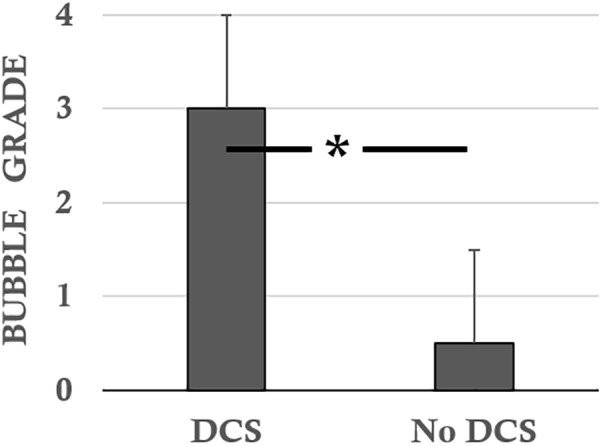
Bubble scores according to the status of the rats following the hyperbaric protocol. ∗ notes significant difference (p < 0.05).